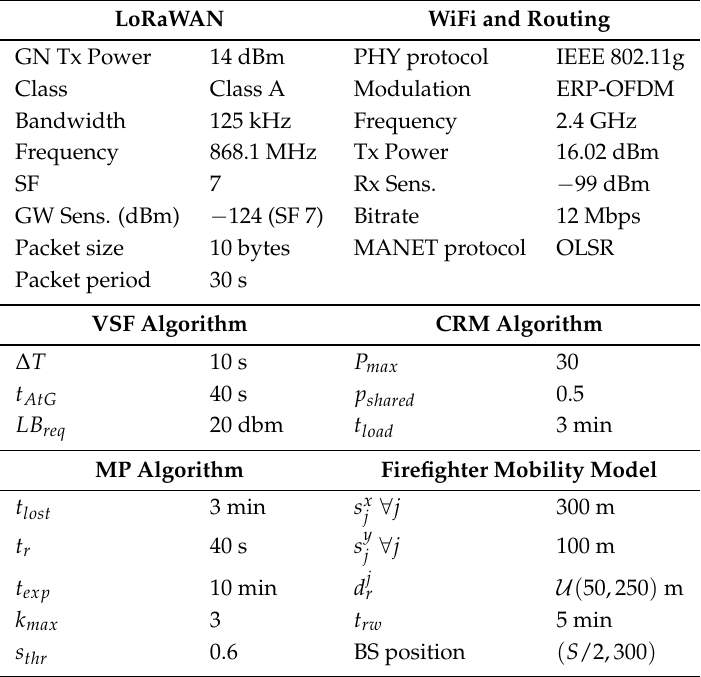
Table 1. List of fixed simulation parameters.